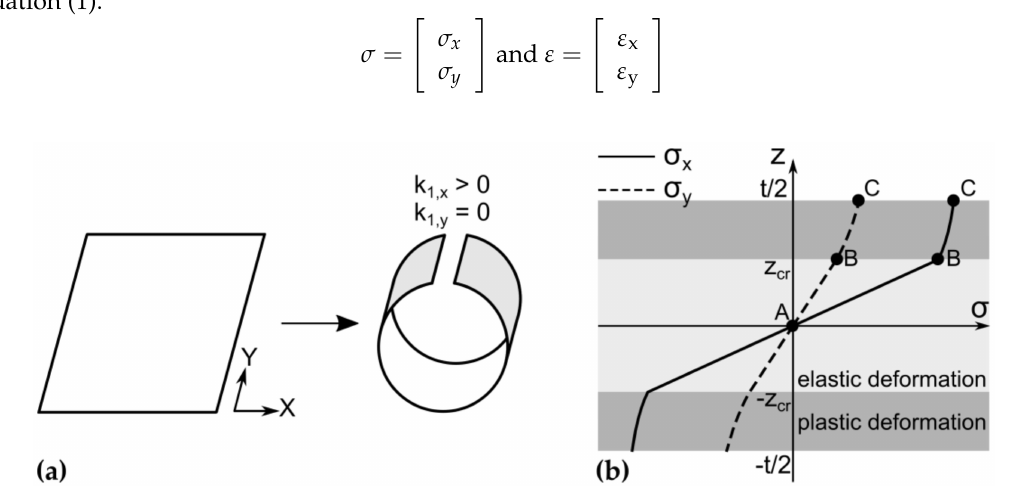
Figure 5. Shell geometry ( a ) and stress distribution along the shell thickness ( b ) after first